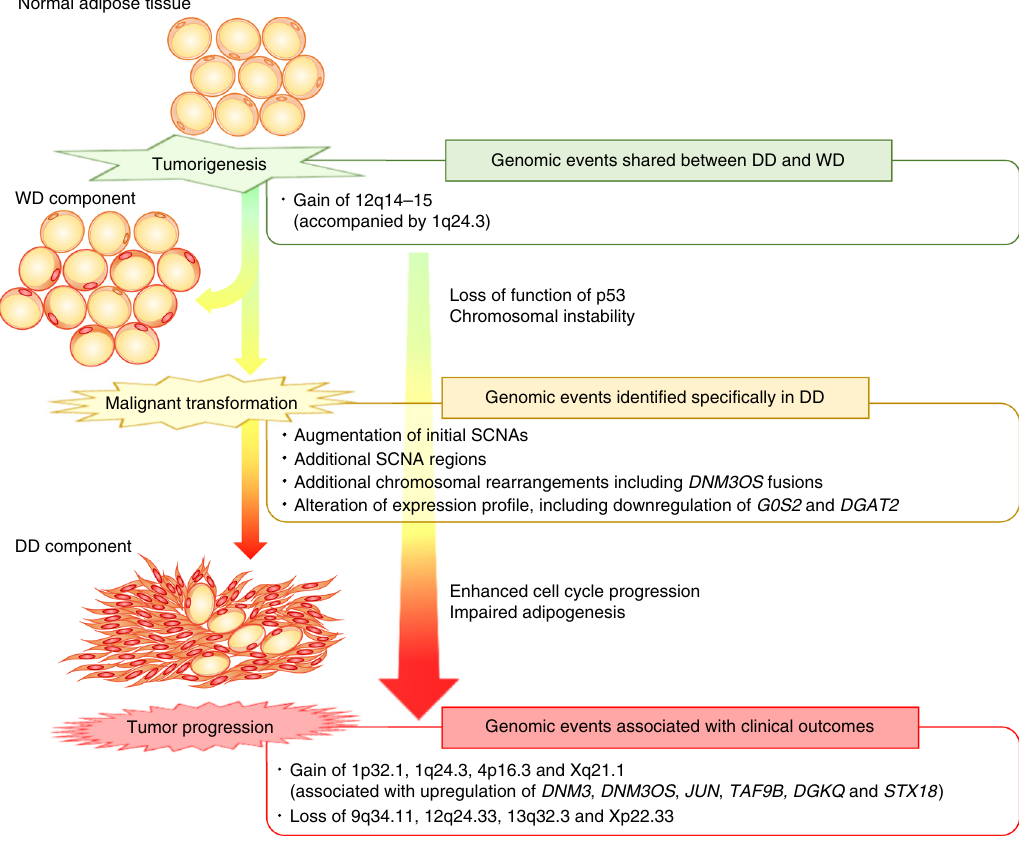
Fig. 5 Scheme of genomic events during DDLPS